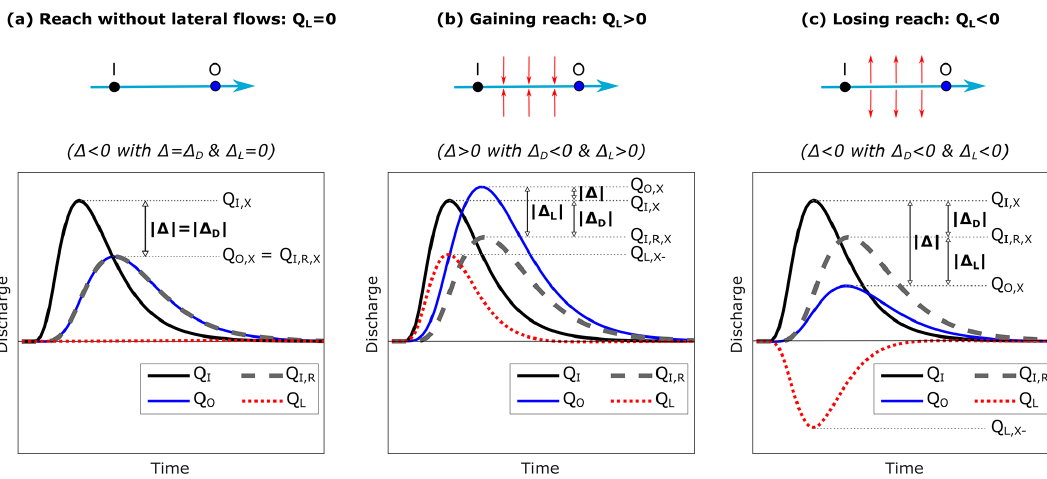
Figure 3. Theoretical examples of simulated lateral hydrographs Q L , with corresponding values of peak-flow variation (cid:49) and its two components (cid:49) D and (cid:49) L . Modified from Charlier et al. (2019). Q O , X and Q I , X are peak flows of the outlet and inlet station hydrographs Q O and Q I , respectively. Q I , R is the theoretical outlet flow without lateral exchange (routed inflow by DWE, with C and D